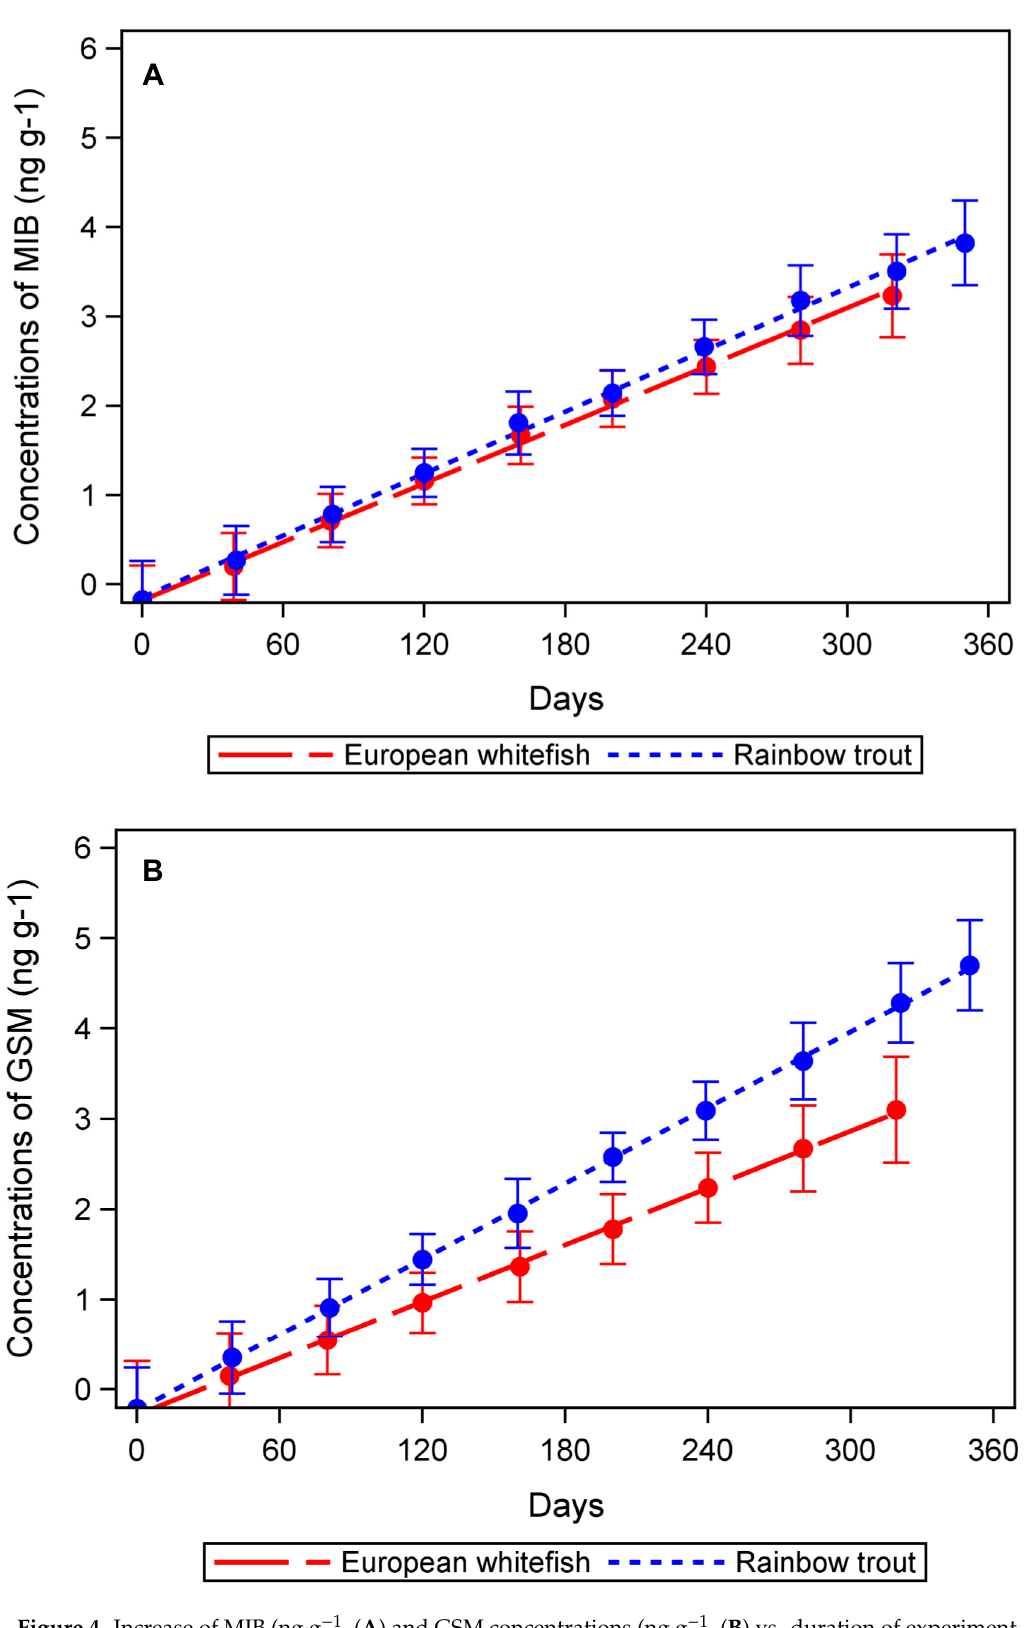
Figure 4. Increase of MIB (ng · g − 1 , ( A ) and GSM concentrations (ng · g − 1 , ( B ) vs. duration of experiment in days after every 40 days, based on the statistical model: rainbow trout (blue line) and European whitefish (red dashed line). Point estimates are shown with 95% confidence interval.